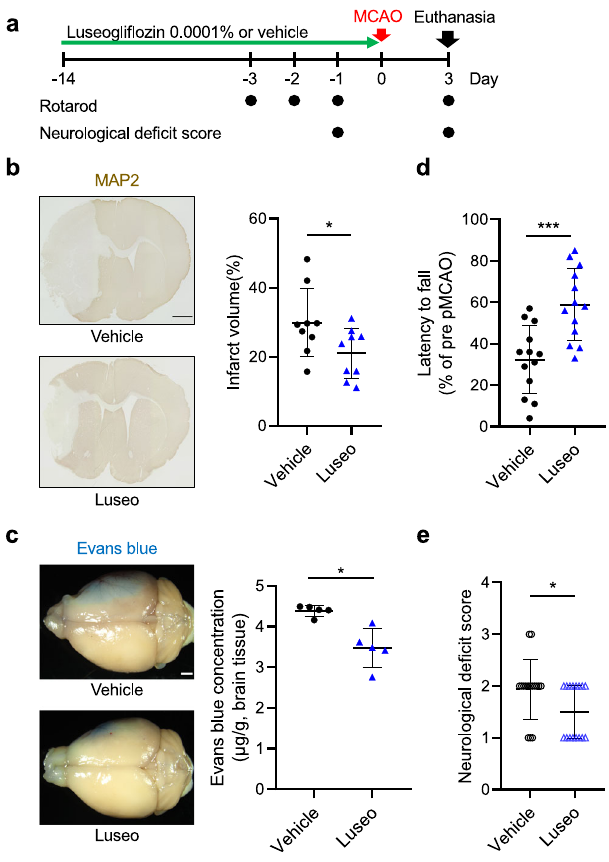
Fig. 1 Luseogli fl ozin administration attenuates ischemic injury and blood- brain barrier disruption after pMCAO. a Luseogli fl ozin (Luseo), mixed in food at a concentration of 0.0001%, was orally administered to C57BL/6JJcl mice for 2 weeks. The mice were then subjected to pMCAO and euthanized 3 days later. Neurological assessments were performed at indicated time points. b Infarct volume at 3 days after pMCAO in vehicle- and Luseo- treated mice. Representative images of the immunohistochemistry for MAP2 and the corresponding quanti fi cation are shown (scale bar = 1 mm, n = 9 mice). c Evans blue dye leakage at 3 days after pMCAO in vehicle- and Luseo-treated mice. Representative macroscopic images and the quanti fi cation are shown (scale bar = 1mm, n = 5). d , e Neurological function was assessed using ( d ) rotarod test ( n = 13 mice) and e modi fi ed neurological de fi cit score ( n = 16 mice) at 3 days after pMCAO in vehicle- and Luseo-treated mice. Data are presented as dot-plots of individual experiments and mean values ± SD. * P < 0.05, *** P < 0.001 by unpaired t -test. Luseo luseogli fl ozin, pMCAO permanent middle cerebral artery